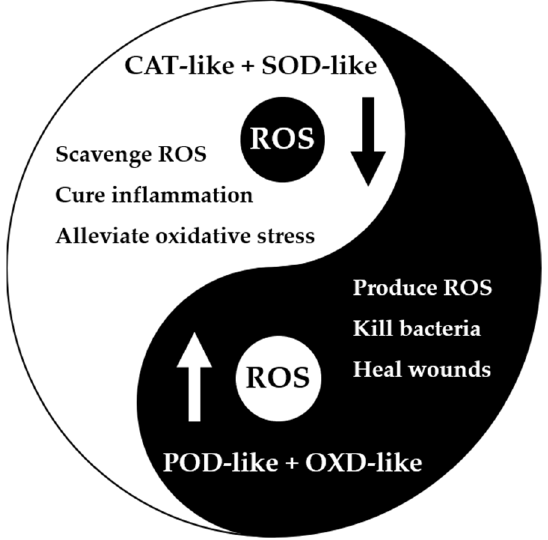
Figure 7. Mechanism of SAzymes for scavenging ROS and antibacterial.